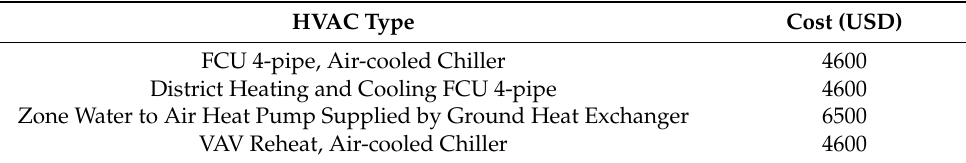
Table 3. The selected active retrofitting